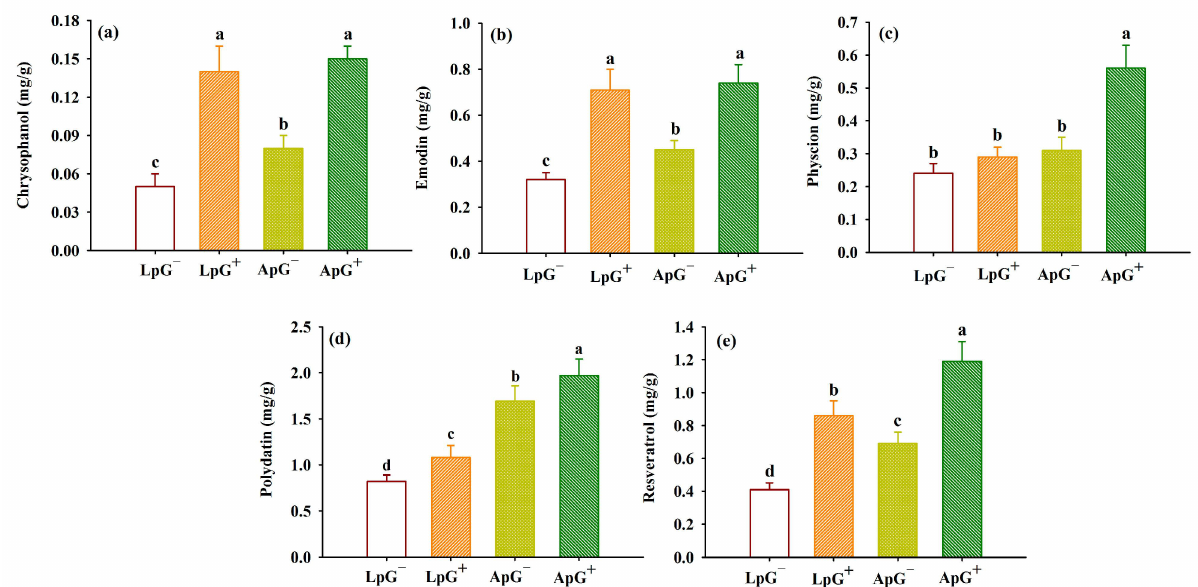
Figure 6. Changes in concentrations of leaf chrysophanol ( a ), emodin ( b ), physcion ( c ), polydatin ( d ), and resveratrol ( e ) of Polygonum cuspidatum inoculated with Glomus mosseae in low and approximate P levels. Different letters in the bars indicate significant ( p < 0.05) differences between treatments. See Figure 1 for